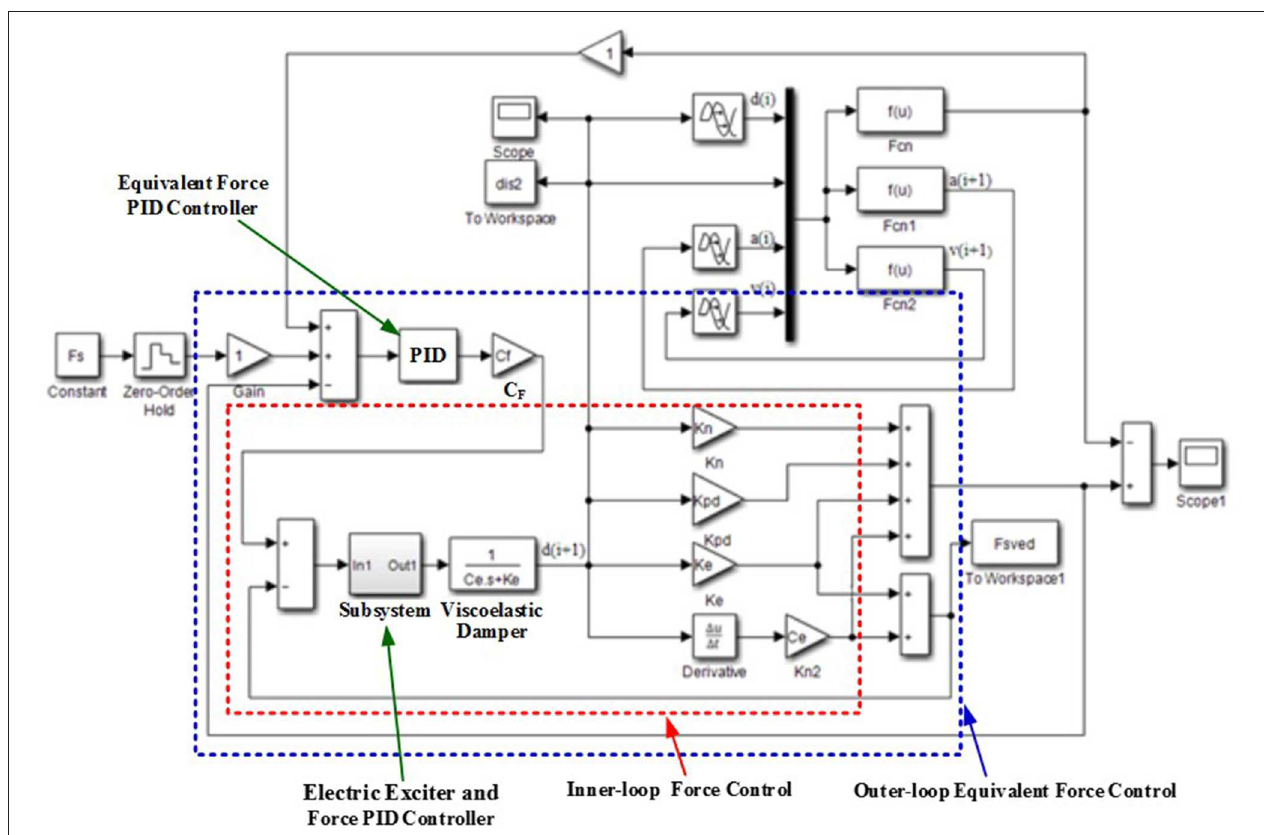
FIGURE 4 | Simulink simulation model of the equivalent control system.